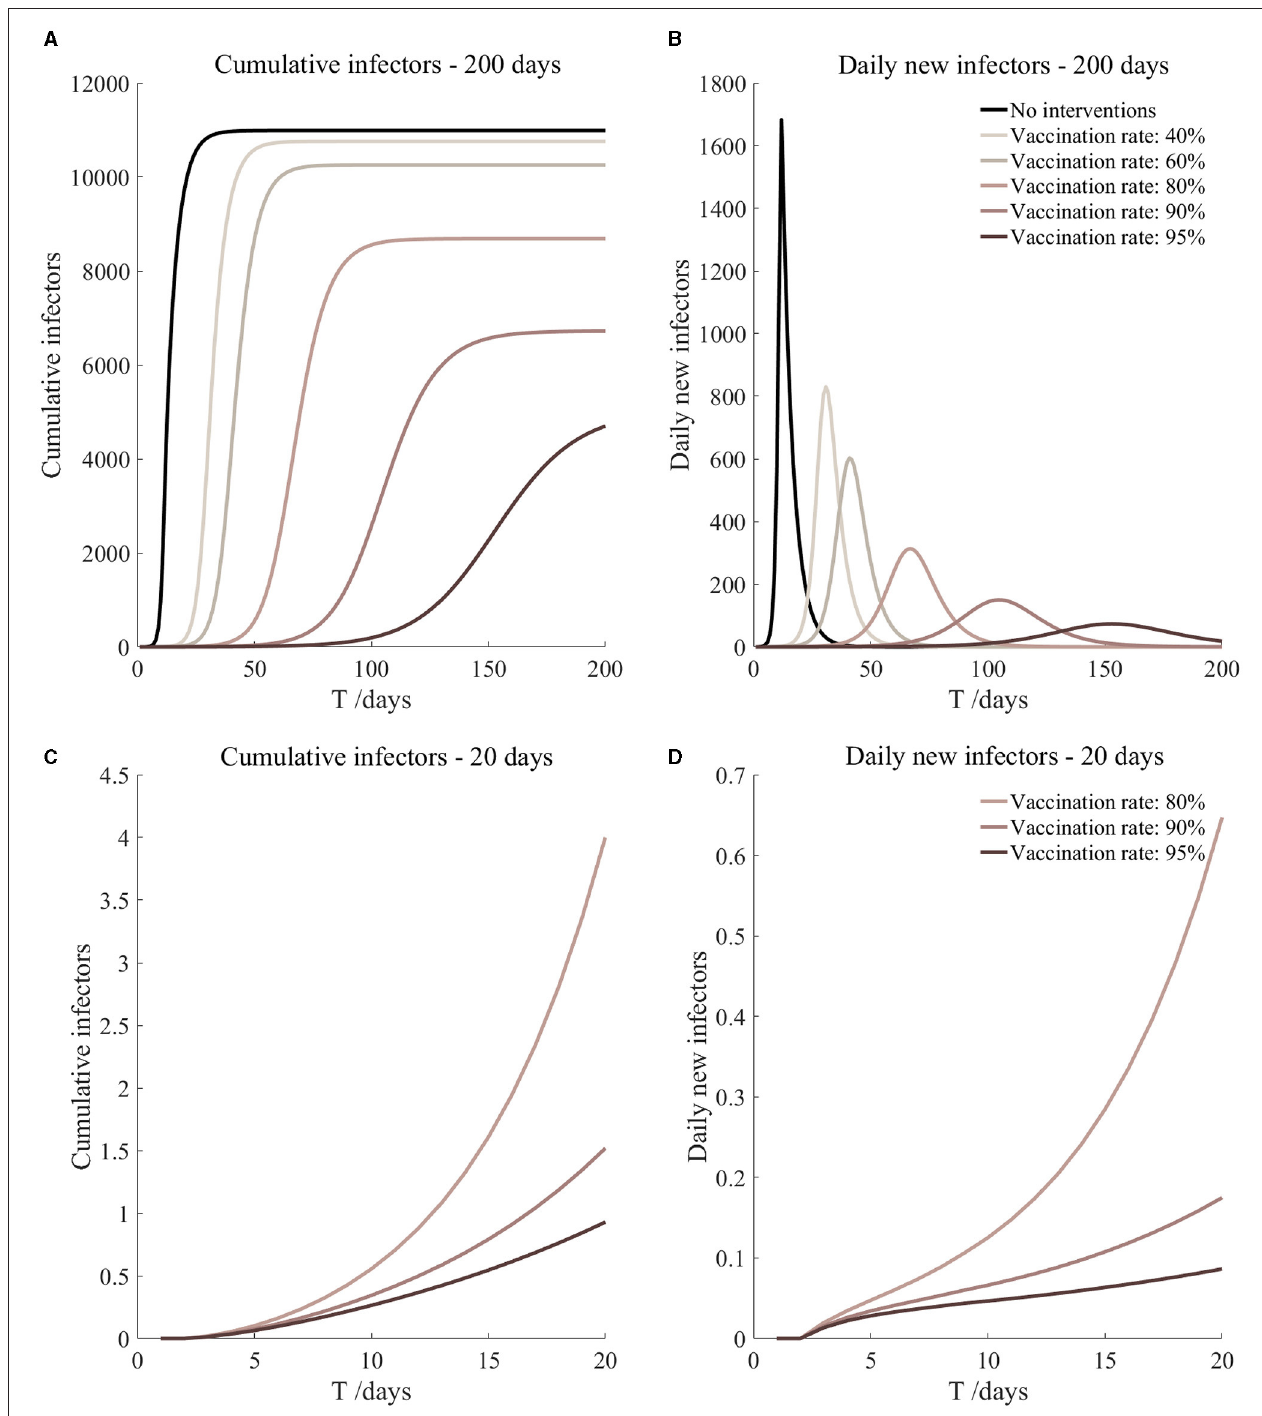
FIGURE 7 | Vaccination and 7-day compulsory quarantine. Assume pre-flight screening can identify 20% of asymptomatic infectors, 7-day compulsory quarantine has about an 18% risk of missed detection.